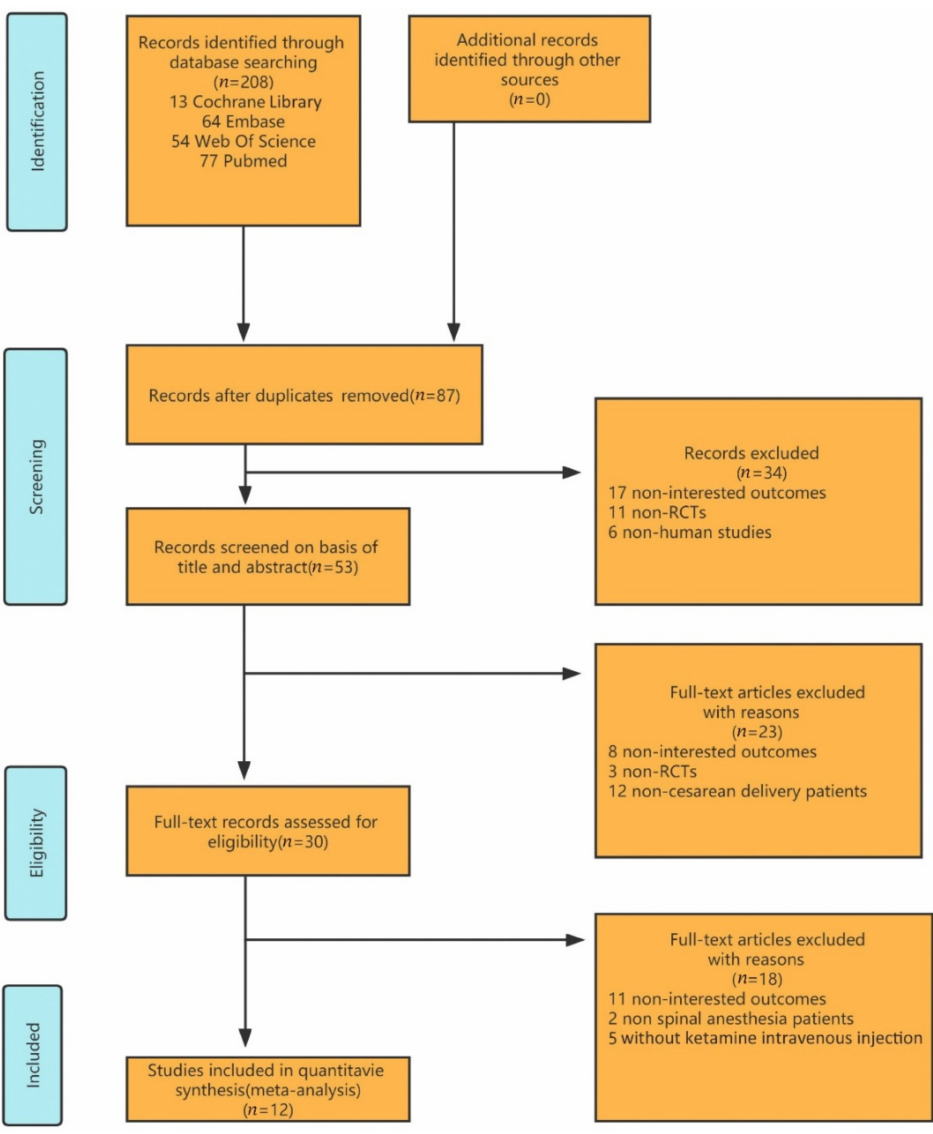
Figure 1. Flow diagram of the study